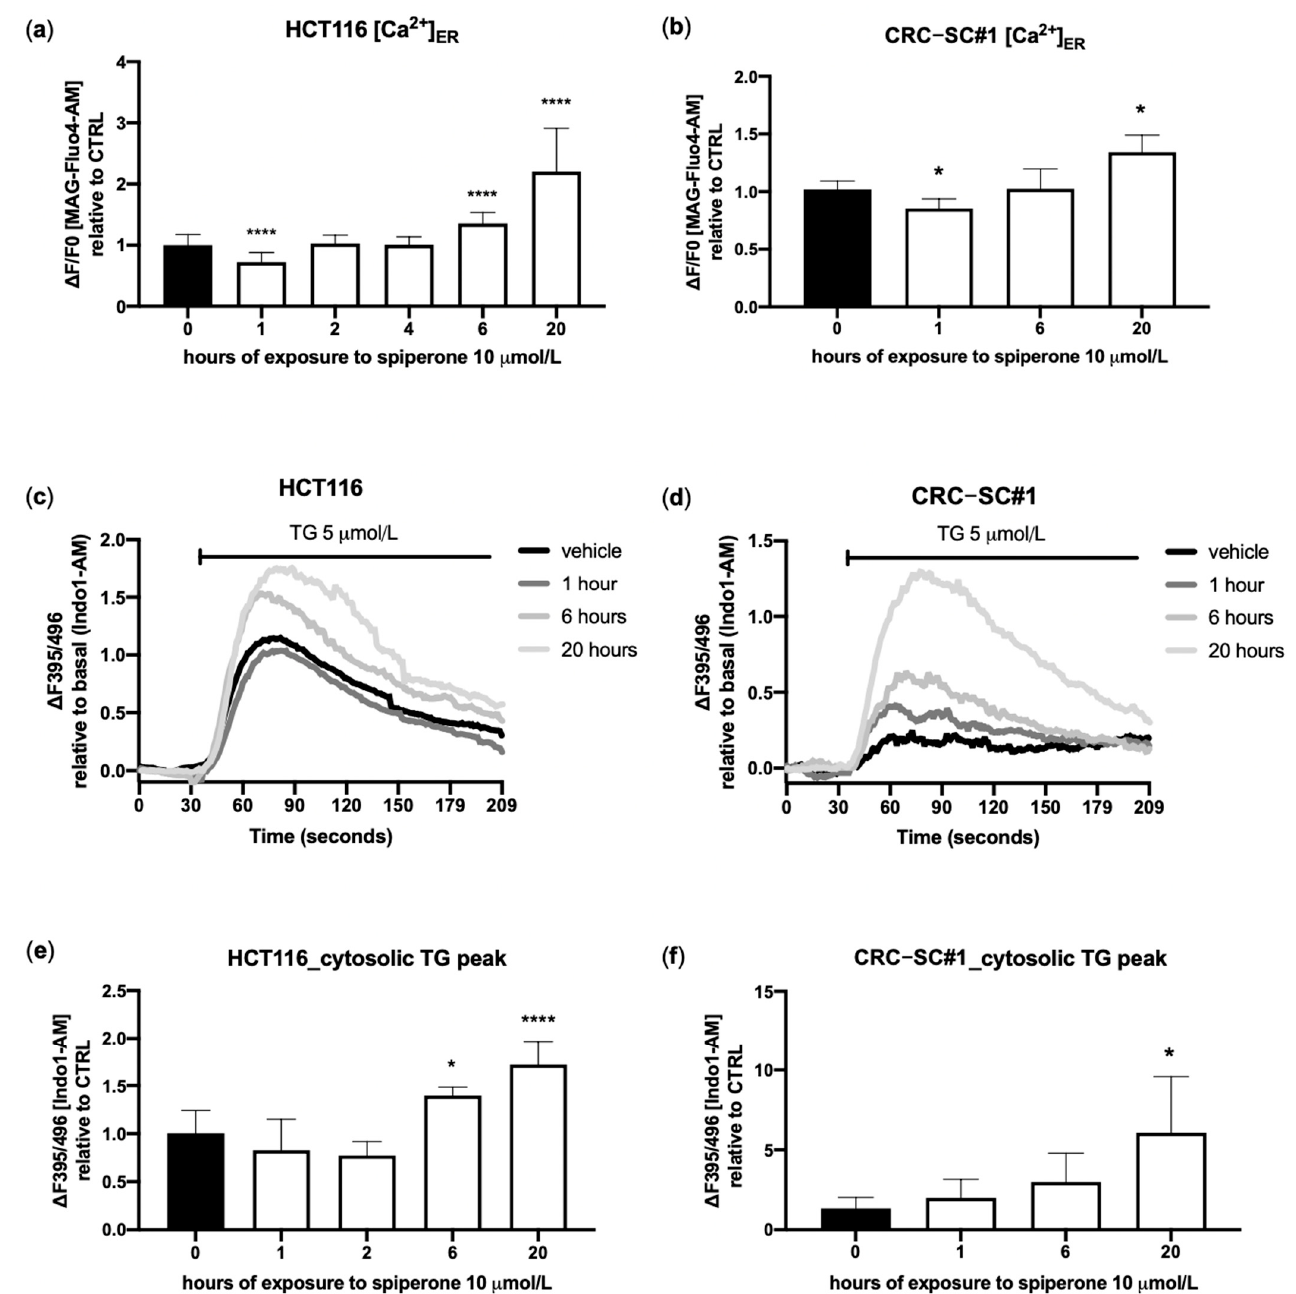
Figure 6. Spiperone induces a long-term increase in [Ca 2+ ] ER and enhances intracellular storage release. [Ca 2+ ] ER was evaluated in HCT116 and CRC-SC#1 cells treated with 10 μ mol/L spiperone at different time points. Histogram displaying fluorescence quantification relative to control signal for Mag-Fluo-4 AM in HCT116 ( a ) and CRC-SC#1 ( b ) cells. [Ca 2+ ] cyt was monitored before and after 5 µ mol/L TG exposure in cells treated with spiperone at different time points. Graph representing the mean of fluorescence kinetics over time in HCT116 cells ( c ) and CRC-SC#1 cells ( d ). Histogram displaying quantification of fluorescence peaks relative to the control signal for Indo-1 after 5 µ mol/L TG exposure in HCT116 ( e ) and CRC-SC#1 ( f ) cells. Data show the mean ± SD of at least three independent experiments. *: Student’s t -test p < 0.05; ****: Student’s t -test p <